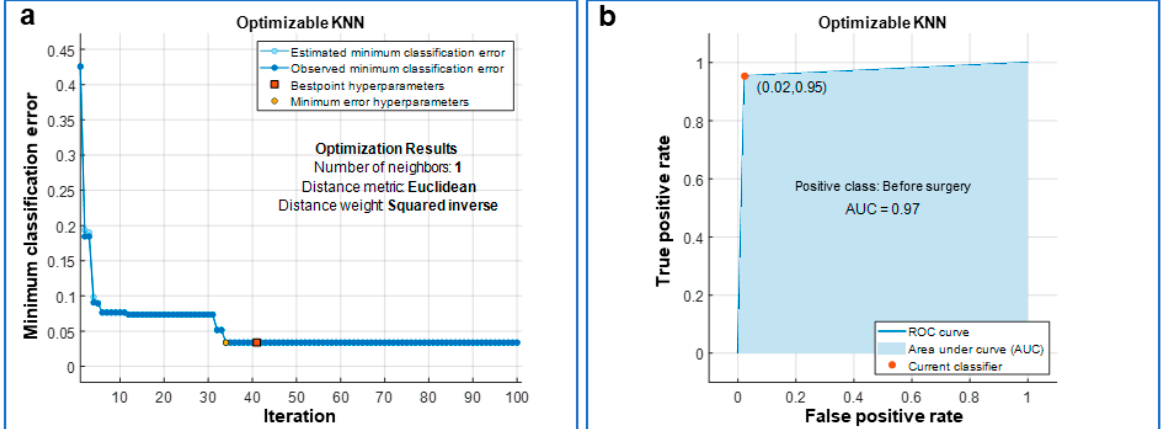
Figure 4. Optimization of the k-nearest neighbor (KNN) classifier. ( a ) The classifier was optimized over 100 iterations via the minimization of the classification error and its optimized hyperparameters are reported as “Optimization Results”. In detail, for each iteration of the optimization, the classifier was also 10-fold cross-validated. ( b ) Receiver Operating Characteristic (ROC) curve with the area under the curve (AUC) painted in blue; a value of AUC close to 1 means a very low classification error for the optimized classifier.